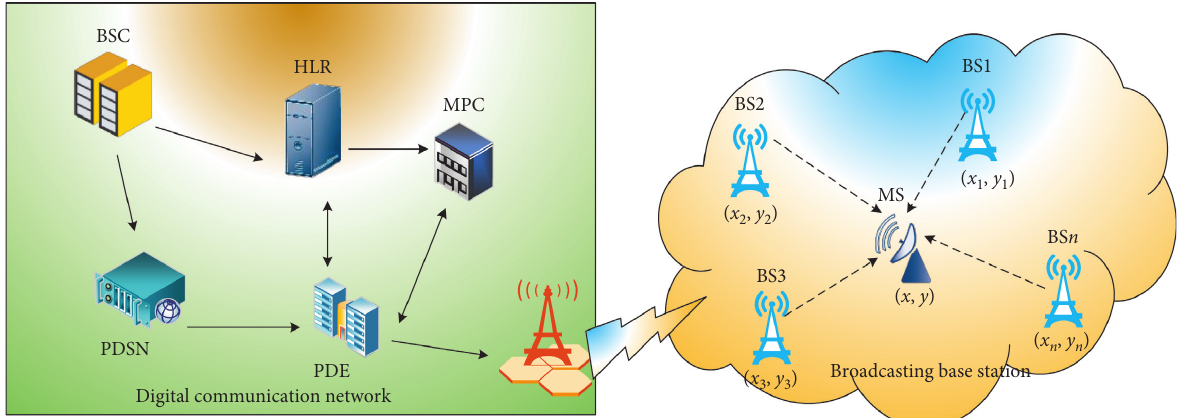
Figure 1: Positioning system based on digital broadcasting